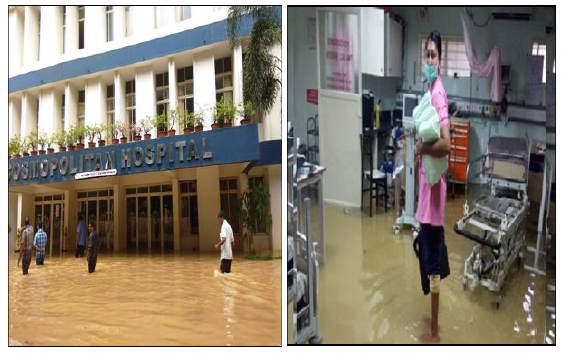
Figure 1 . Inundated hospital facility and inundated ICU in an HCI facility during a